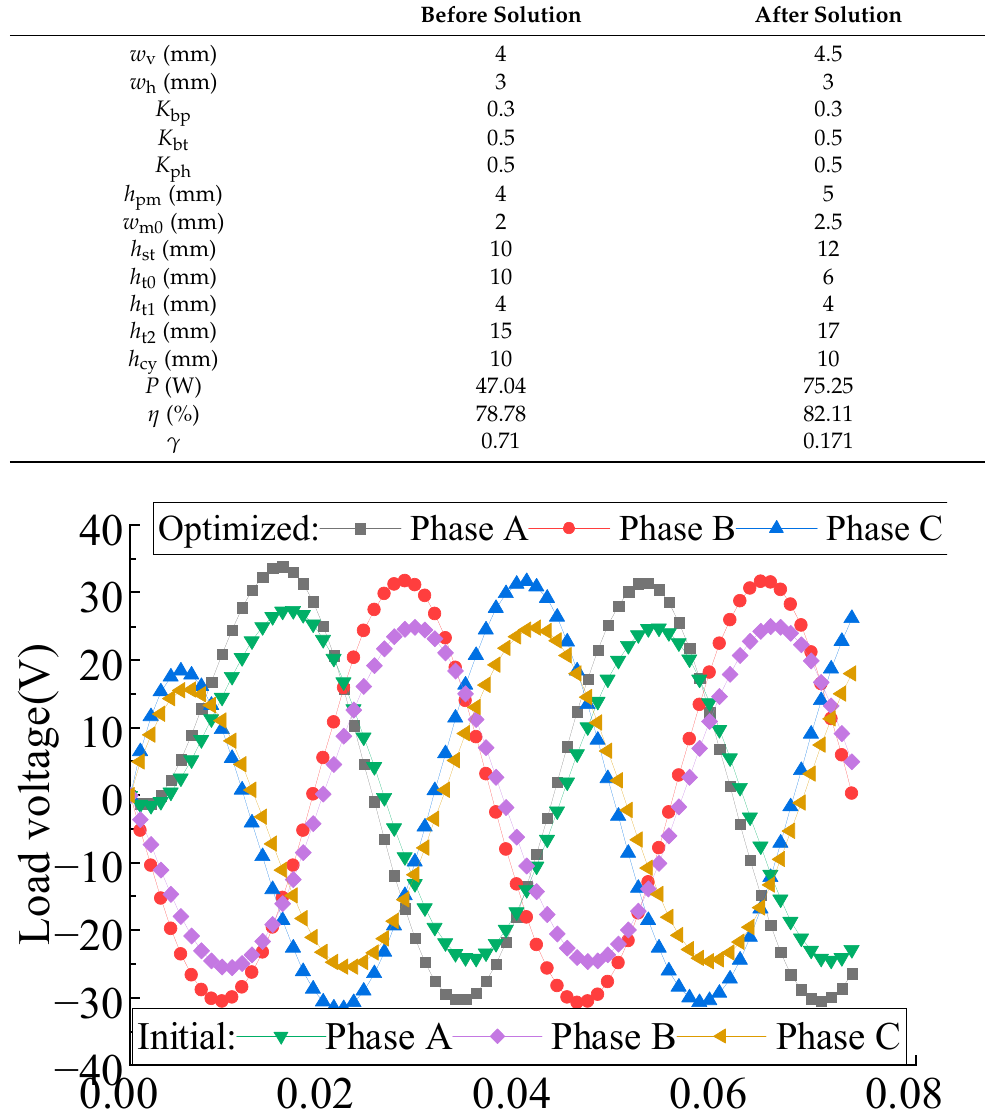
Phase C Figure 19. Comparison of load current.